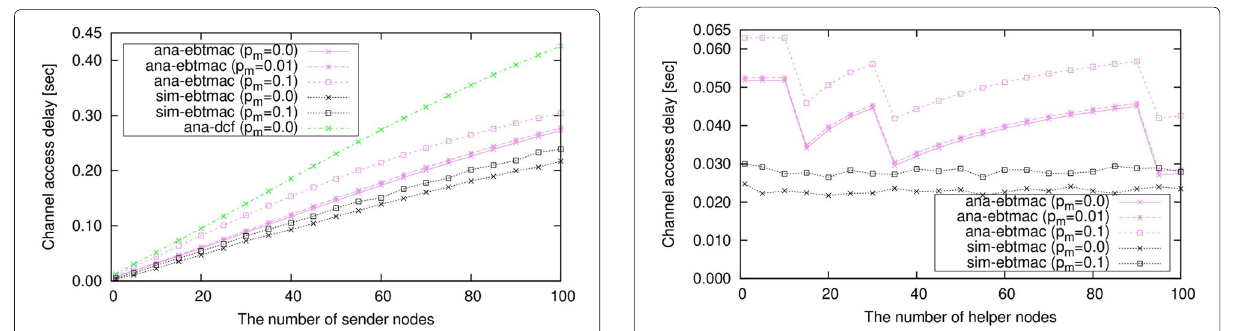
Fig. 12 Delay performance as a function of N